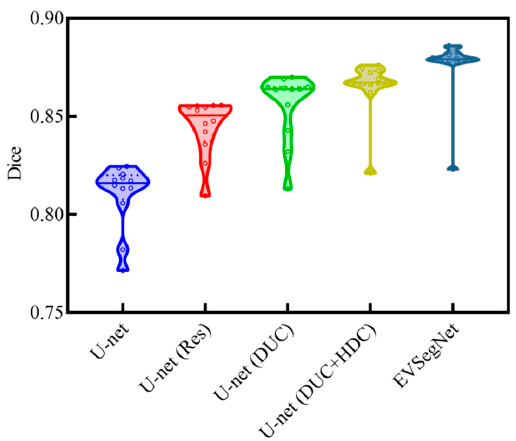
Figure 6. Illustration of segmentation results of VWI dataset. The first column represents the original image, the second column represents the mask, the third column is binary mas, the fourth represents the edgemaps, which are generated by using Canny filter, and the last column is the corresponding results of the prediction.